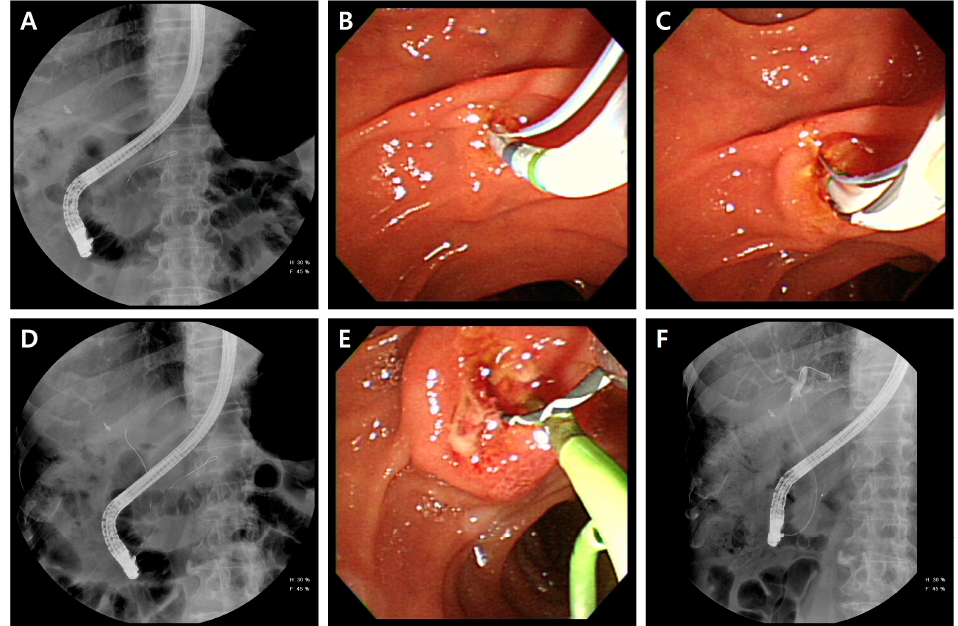
Figure 2. Transpancreatic sphincterotomy technique. ( A ) Fluoroscopy image showing the guidewire inserted in the pancreatic duct. ( B ) The septum was cut with a sphincterotome from the pancreatic duct towards the bile duct axis. ( C ) The cannulation toward the bile duct was performed while leaving the guidewire in the pancreatic duct. ( D ) Selective bile duct cannulation was successfully achieved. ( E ) The placement of pancreatic duct stent. ( F ) After prophylactic pancreatic stenting, termination of all procedures.